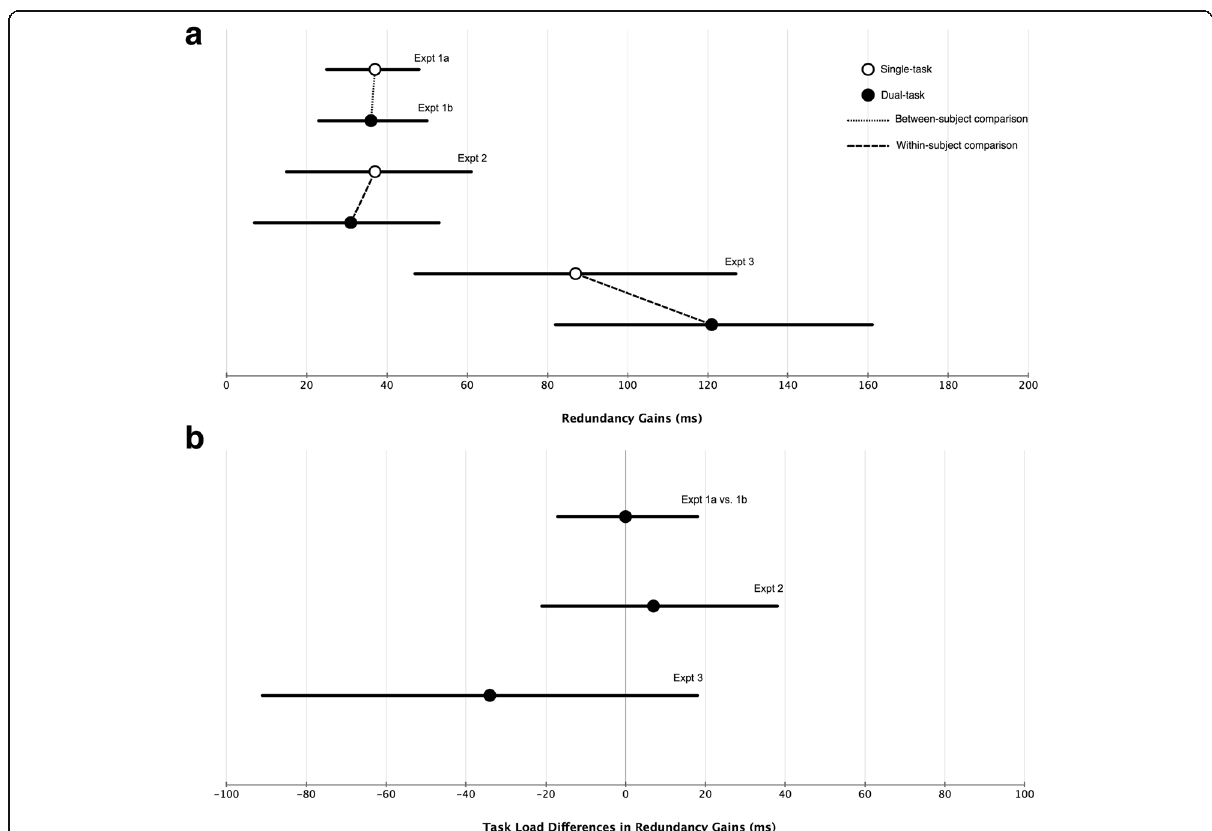
Fig. 3 a Means and 95% BCIs for redundancy gains (ms) by experiment. b Means and 95% BCIs for task-load differences in redundancy gains (single- task RT minus dual-task RT) by